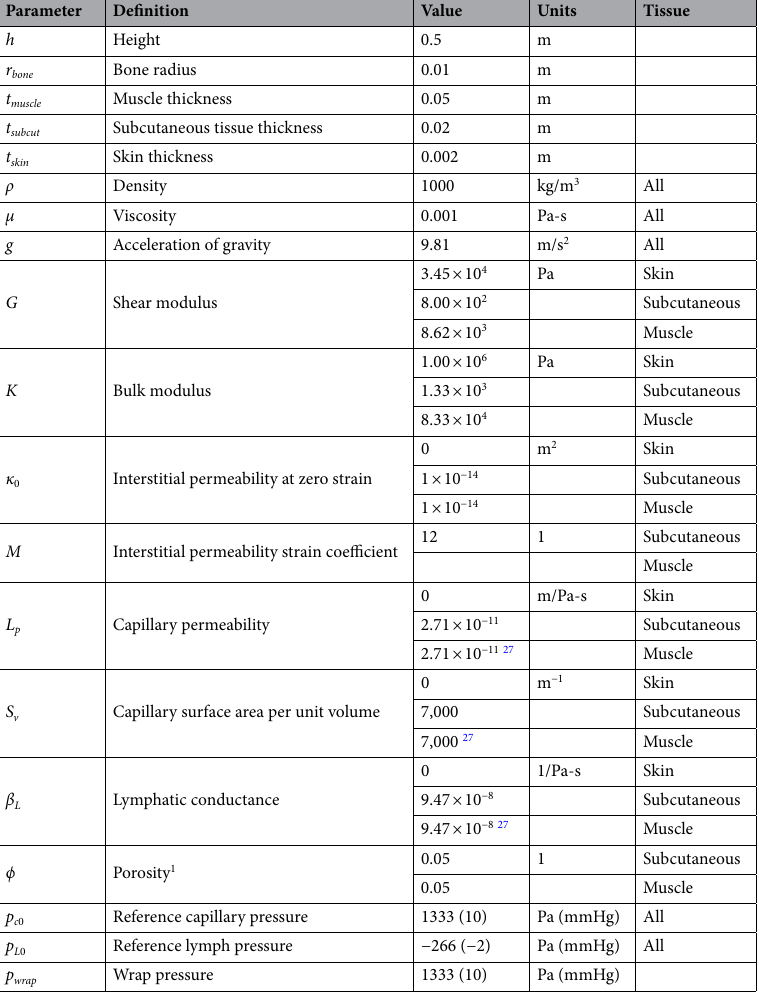
Table 1. Baseline parameter values. 1 The porosity provided here is a nominal initial value. The final results are insensitive to this value since the tissue permeability is calculated dynamically as a function of volumetric strain with Eq.